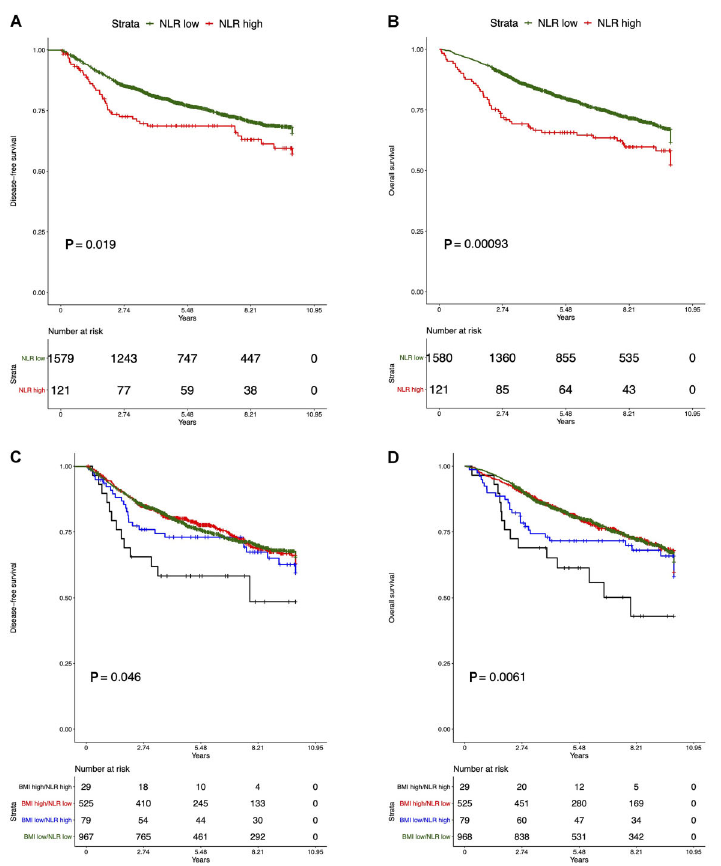
Figure 3. Survival analysis of stage I to III breast cancer patients, according to the neutrophil-to-lymphocyte ratio (NLR). A , Disease-free survival; B , overall survival. Curves ( C and D ) show disease-free survival and overall-survival for combined groups of NLR and body mass index (BMI), respectively. The black line indicates the patients with both NLR high ( 4 4) and BMI high ( X 30 kg/m 2 ), who had the worst